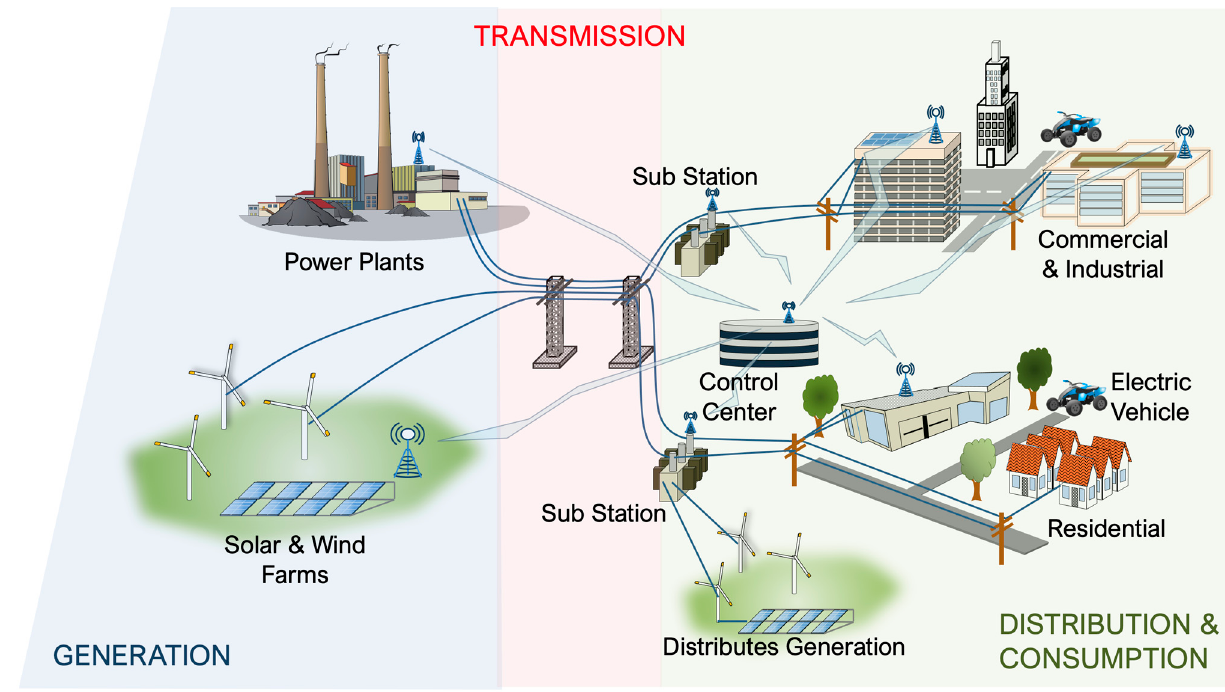
Figure 10. Intelligent interconnection model “Distributed Smart Grid” [107].